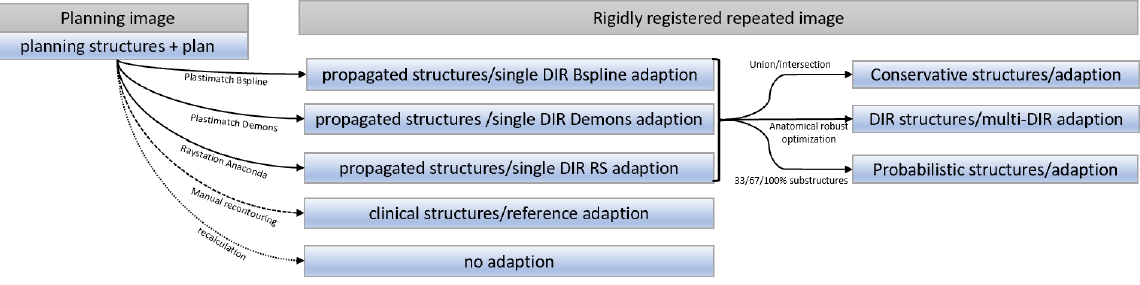
Figure 2. Scheme of the workflow. Doses were calculated on rigidly pre-registered repeated images. Three different DIRs were applied for structure propagation between this repeated image and the planning images. The structures propagated with these DIRs were used for ‘single-DIR plan adaptation’. Information from all 3 DIRs was combined by using their union (for organs and HN target) and intersection (liver and pancreas target) structures for the conservative plan adaptation approach, and substructures were defined according to the frequency that each voxel was defined as belonging to a certain structure for the probabilistic optimization. All adaptive plans were evaluated using the clinical structures drawn by a physician.